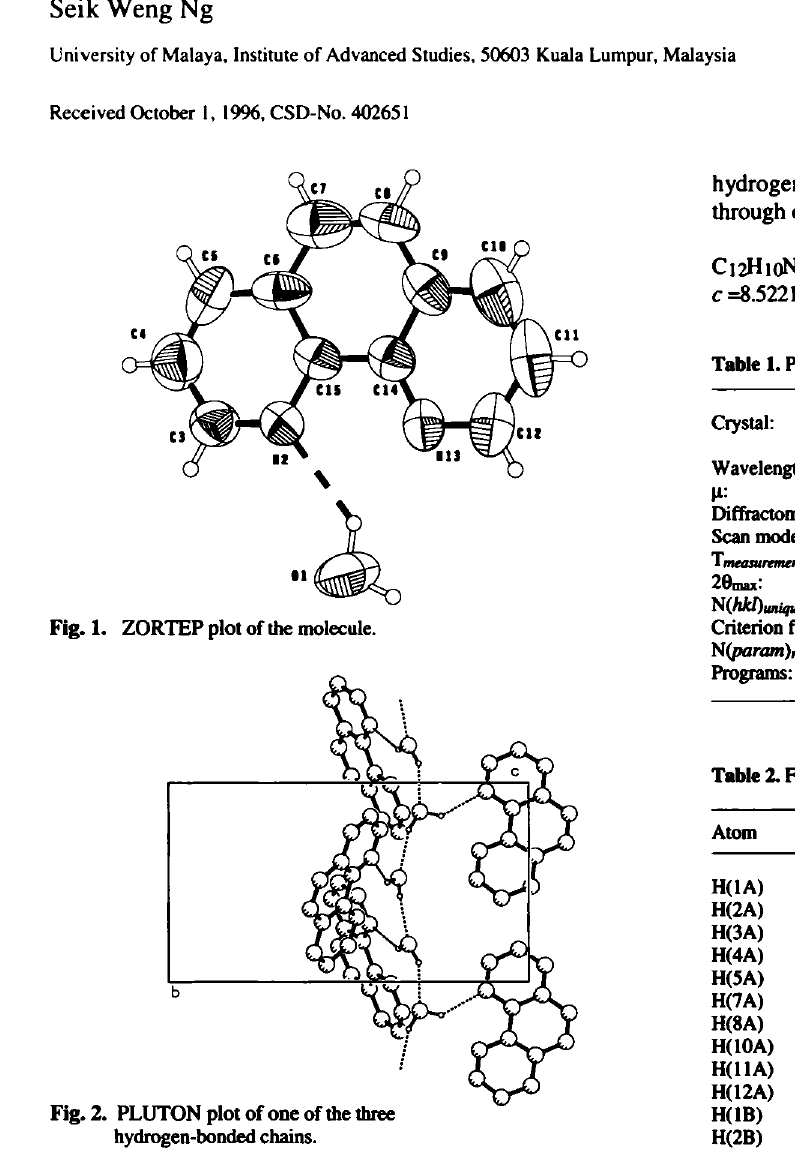
Table 2. Final atomic coordinates and displacement parameters (in À 2